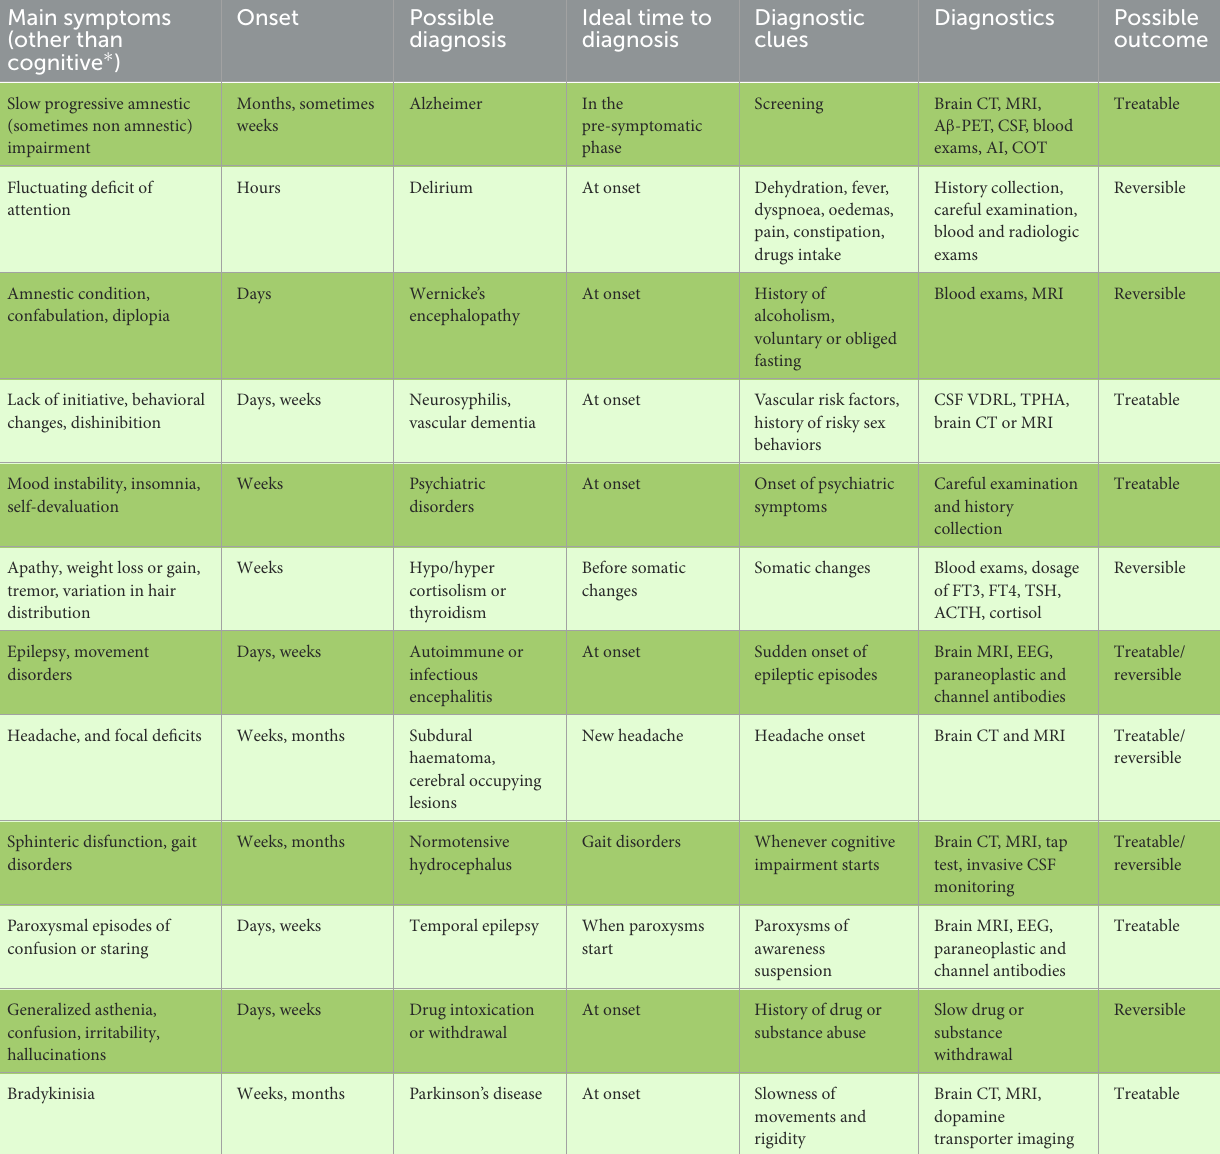
TABLE 1 Dementing pathologies classified by main symptoms, clues to suspicion, ideal time to diagnosis and main exams needed. Main symptoms (other